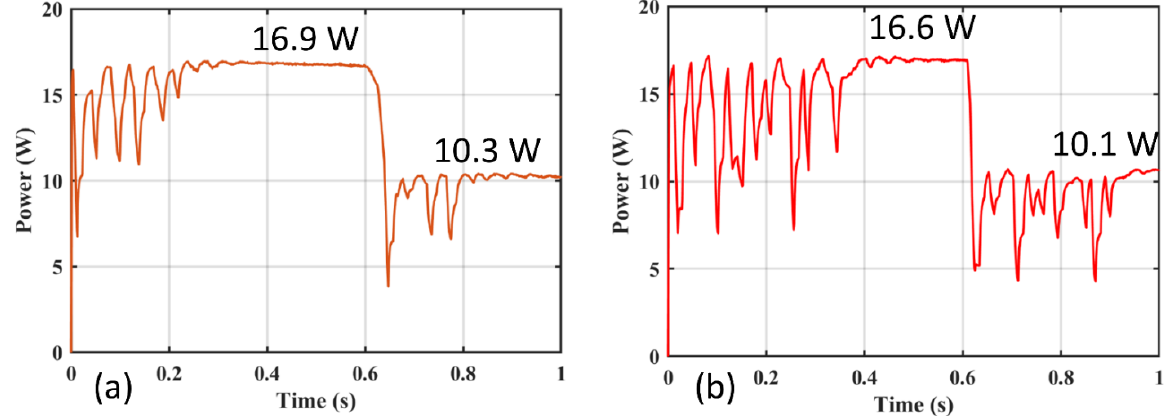
Figure 25. ( a ) Power tracked by BMO and ( b ) power tracked by PSO.